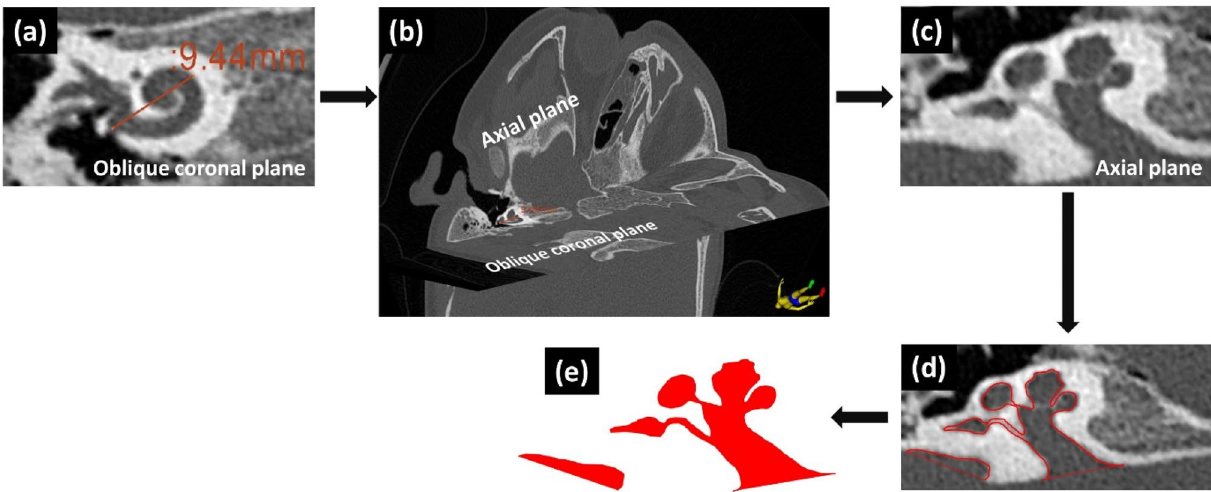
Figure 1. Steps involved in capturing the outer contour of the inner ear in the axial plane. Step-1: A-value measurement in the oblique coronal plane ( a ). Step-2: Along the A-value line and perpendicular to the oblique coronal plane is the axial plane ( b ). Step-3: Capture the axial plane from the step 2 ( c ). Step-4: Drawing manually along the grey-scale difference between the fluid filled and the bony region to capture the outer contour of the inner ear ( e ). Step-4: Filling the outer contour with color to finish the overall process of capturing the outer contour of the inner ear in the axial plane ( e